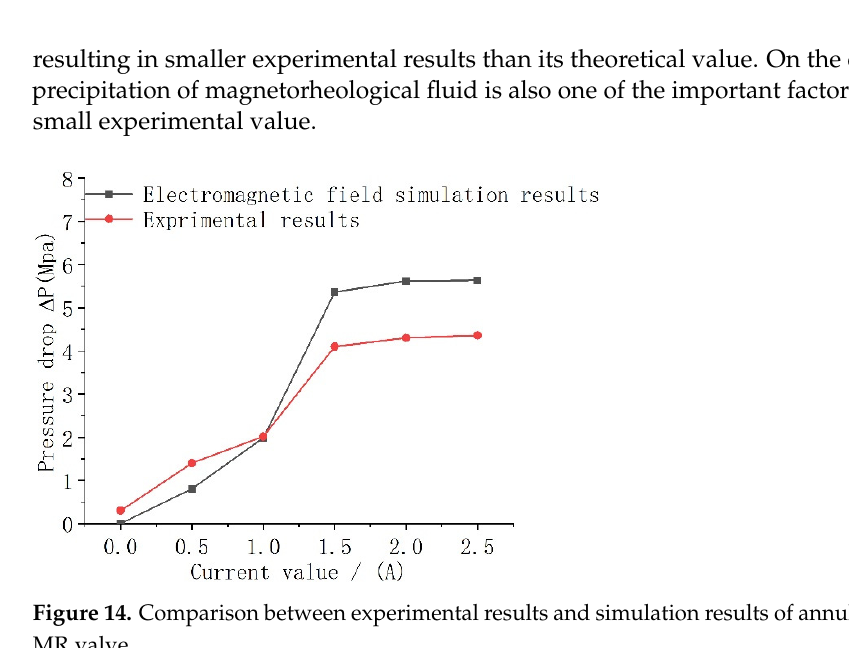
Figure 14. Comparison between experimental results and simulation results of annular multi-chan- nel MR